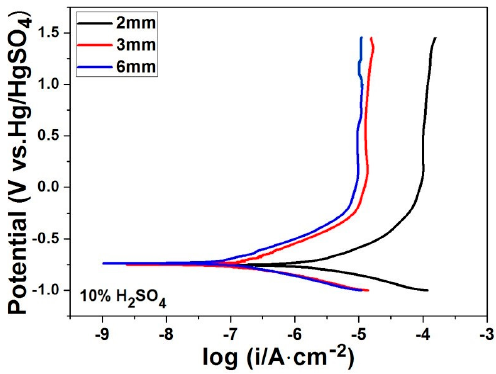
Figure 2. The potentiodynamic polarisation curves for in-situ Ti 46 Zr 20 V 12 Cu 5 Be 17 metallic glass matrix composites (MGMCs) with diameters of Φ 2, Φ 3, and Φ 6 mm in the 10% H 2 SO 4 solution at room temperature.